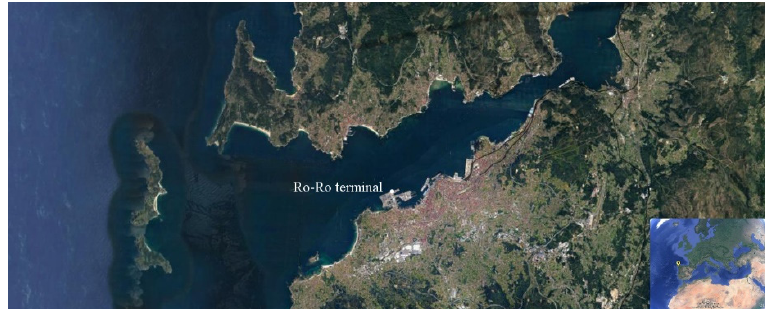
Figure 2. Ro–Ro terminal location in Port of Vigo. Source: Google Earth, 2020.